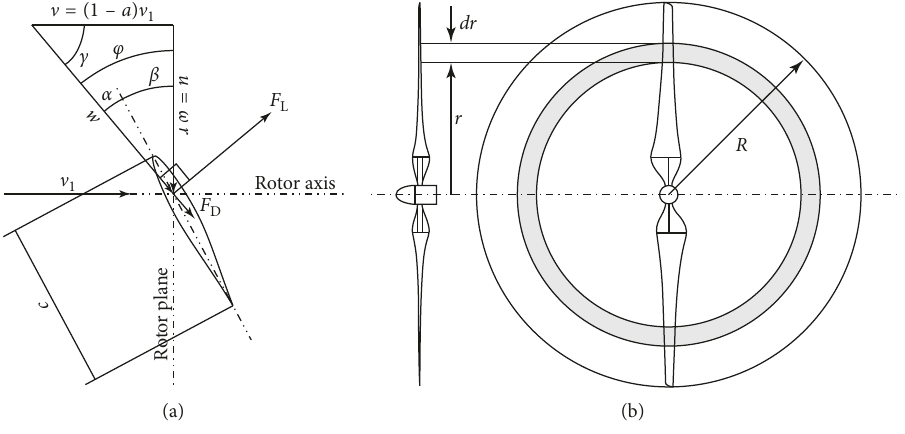
Figure 3: The main geometric features of the wind